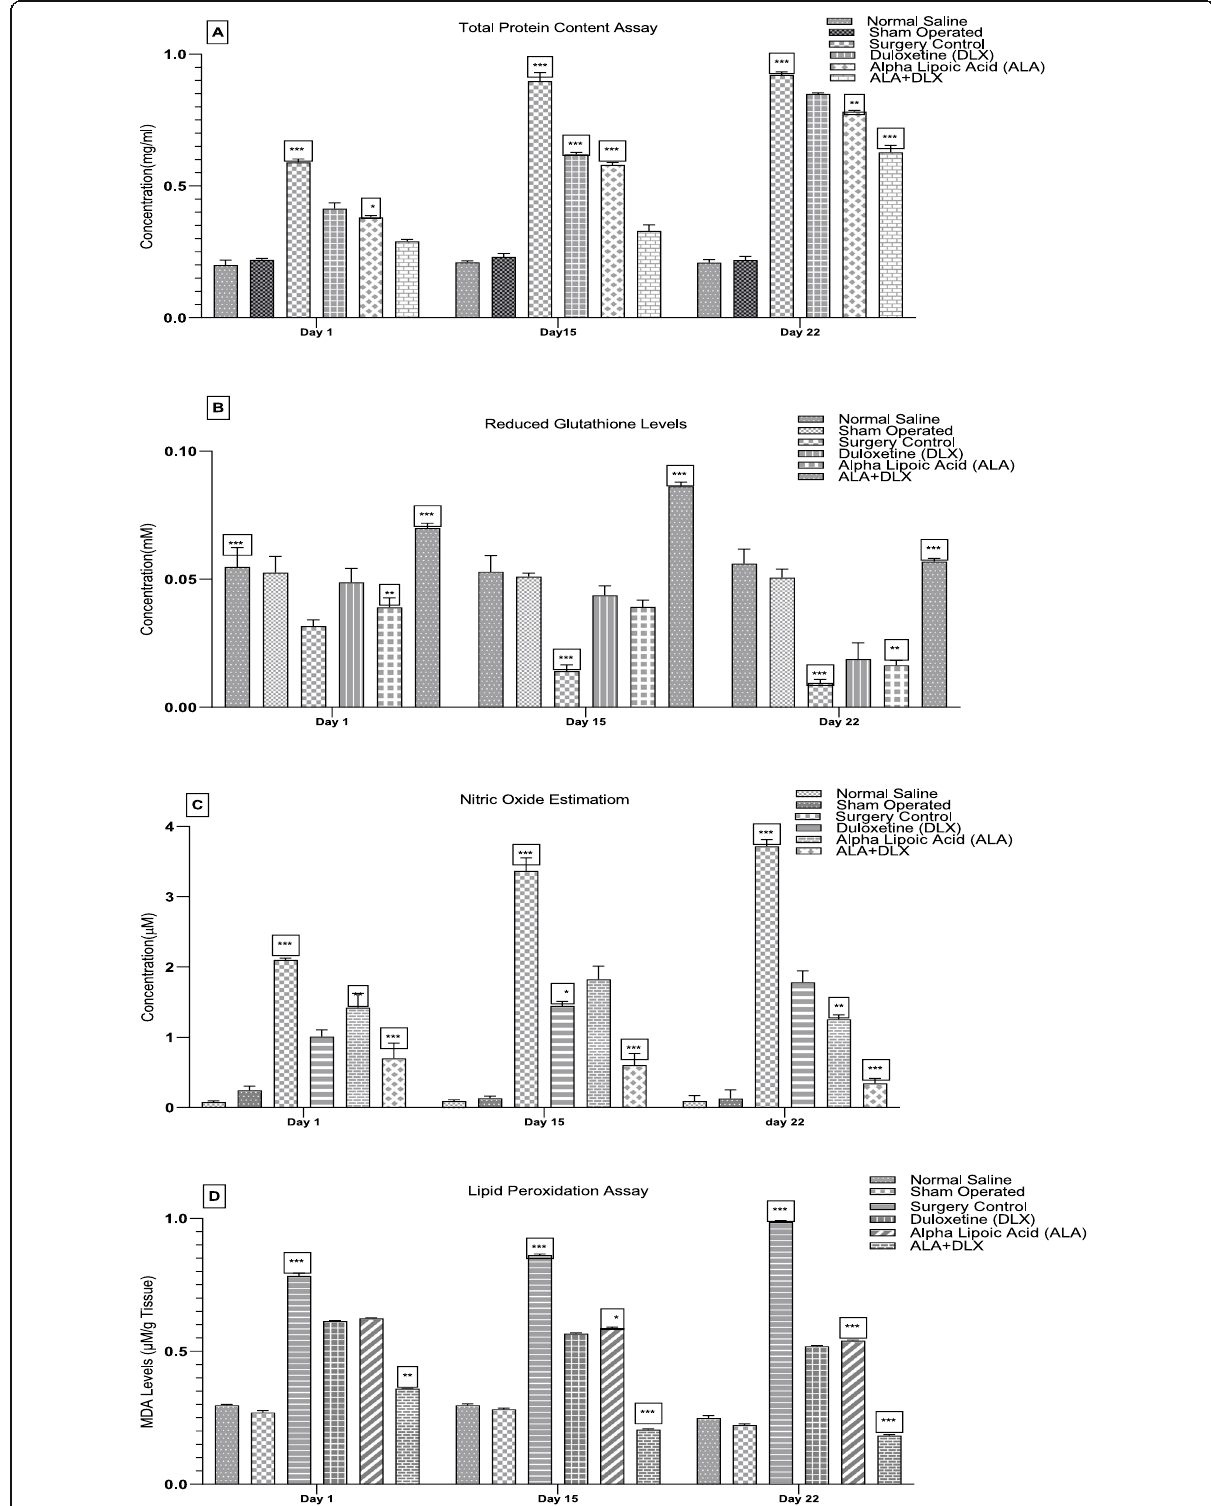
Fig. 1 Effect of ALA (25 mg/kg/i.p), DLX (30 mg/kg/p.o), Combination (ALA + DLX) (25 mg/kg; IP,30 mg/kg/p.o) on paw withdrawal latency in thermal hyperalgesia, flicking response in cold allodynia and grip strength in motor coordination test. Data expressed as mean ± SEM ( n = 8) rats per group, analysed by two-way ANOVA followed by Tukey ’ s multiple comparisons test. p < 0.05 (*), p < 0.01 (**), p < 0.001